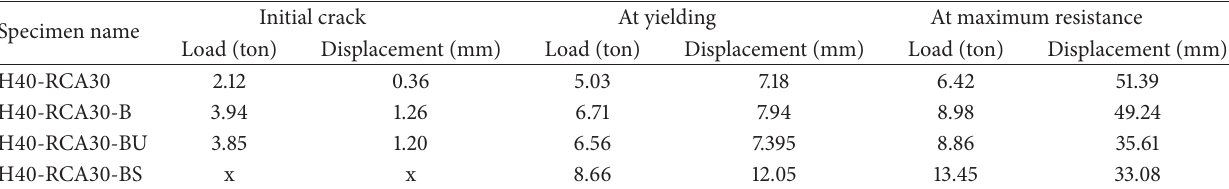
Table 6: Experiment result.